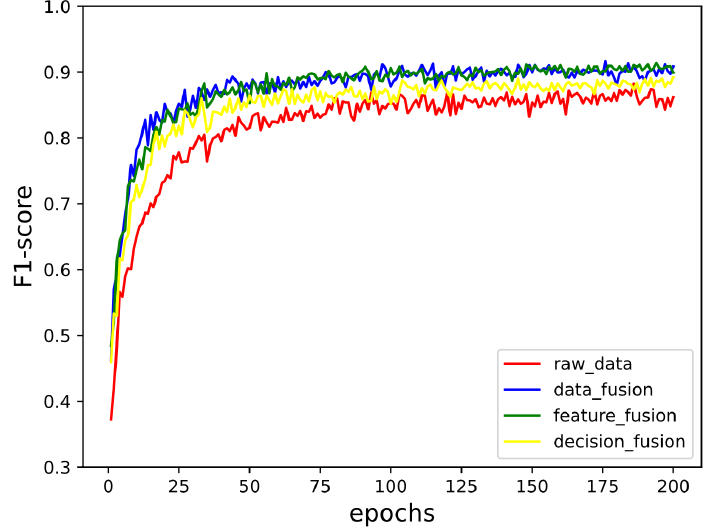
Figure 8. The changes of F1-score in the training process on VPN2016.